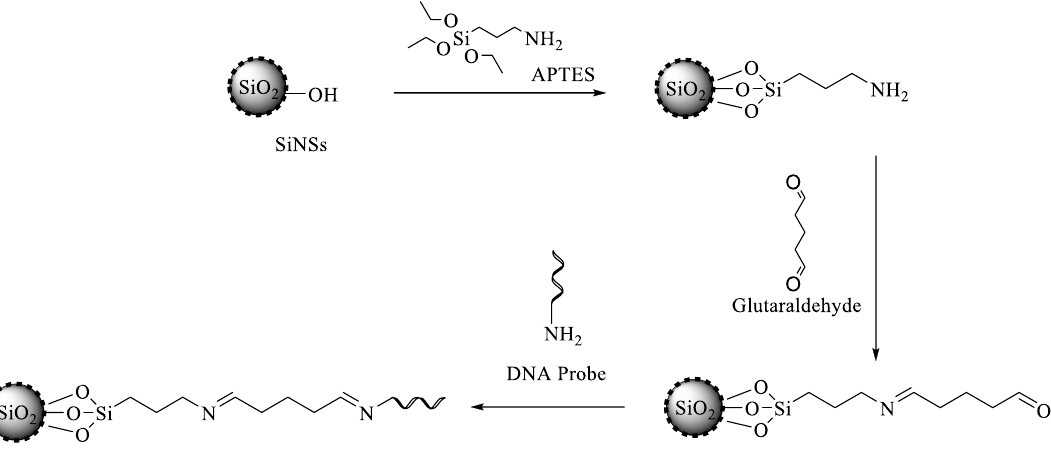
Figure 1. Proposed chemical reaction for the fabrication of porcine DNA probe.